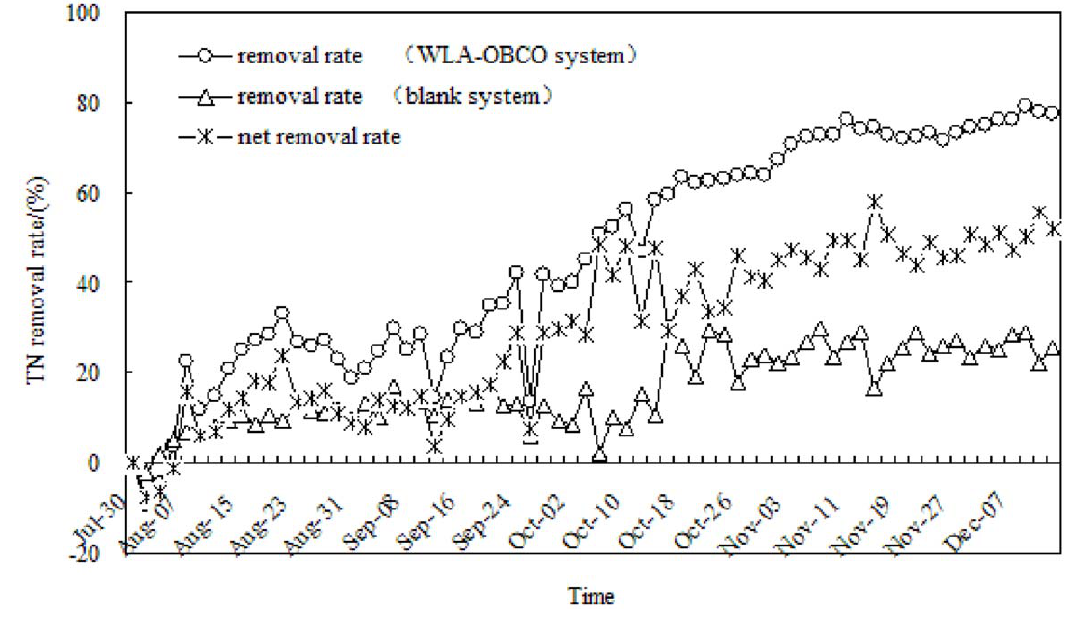
Figure 3. Denitrification effects of WLA-OBCO combined system during operation.